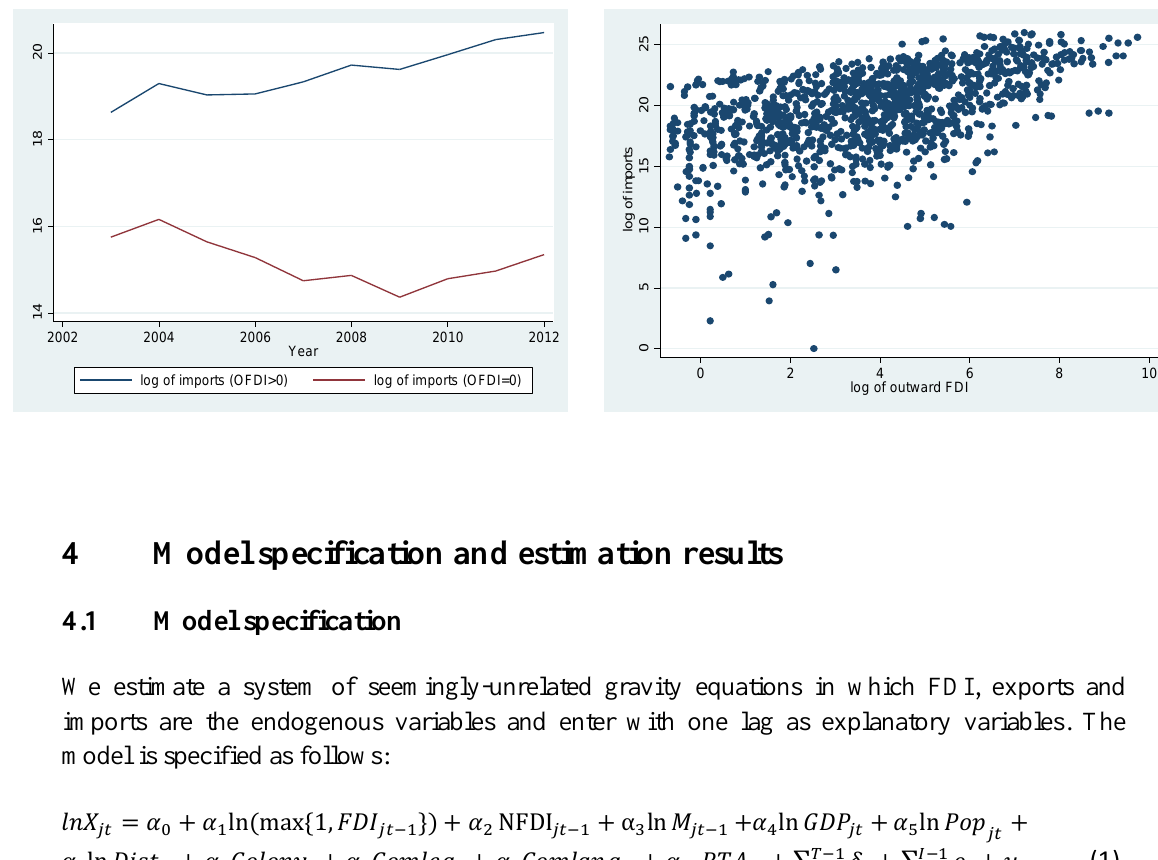
Figure 3 .Chinese Imports by FDI status Figure 4. Chinese Imports and